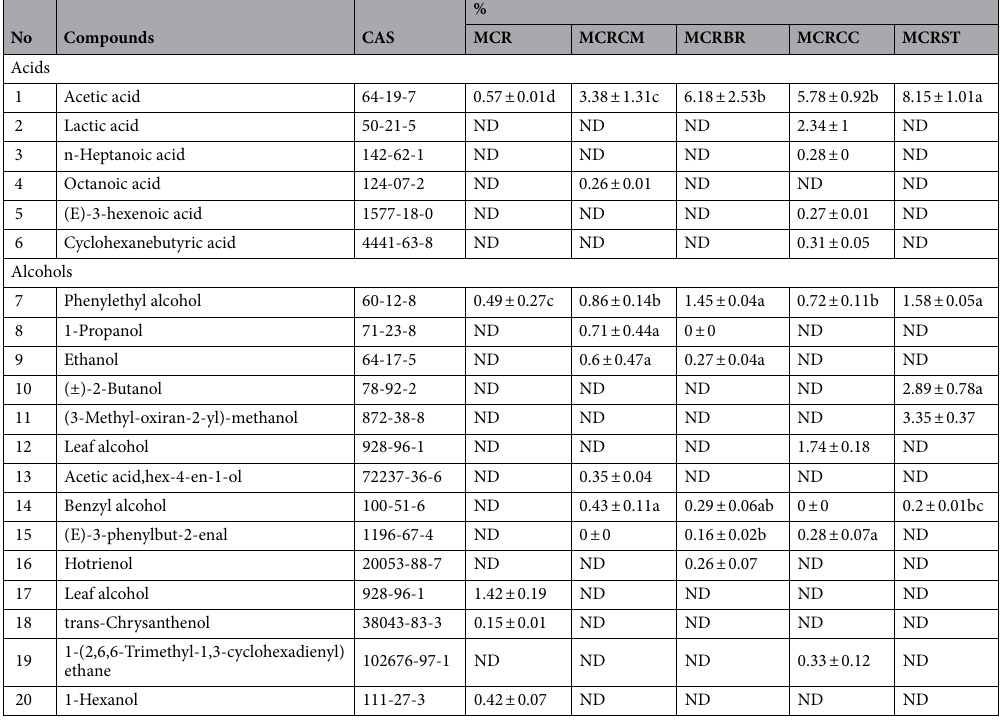
Table 2. Effects of mixed ensilage on the VOCs of alcohols and acids in MCR.